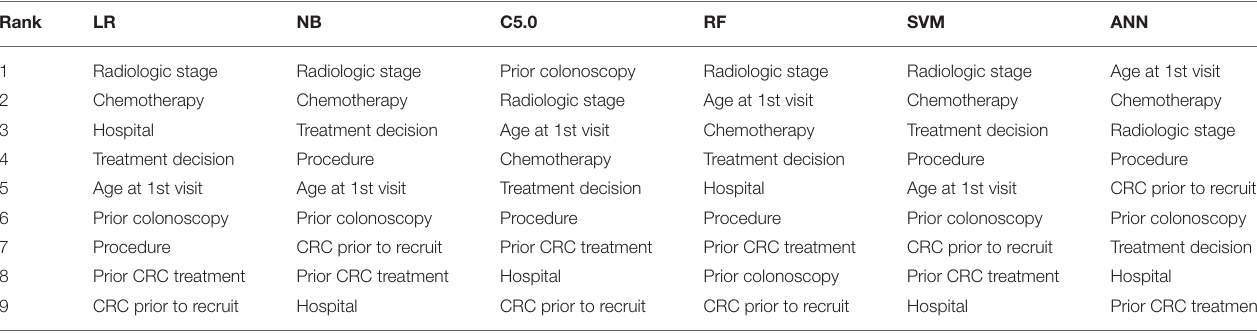
TABLE 2 | Risk factor ranking in descending order showing the relative importance of each feature to modelling WDGMC CRC recurrence as ranked by each predictive models.